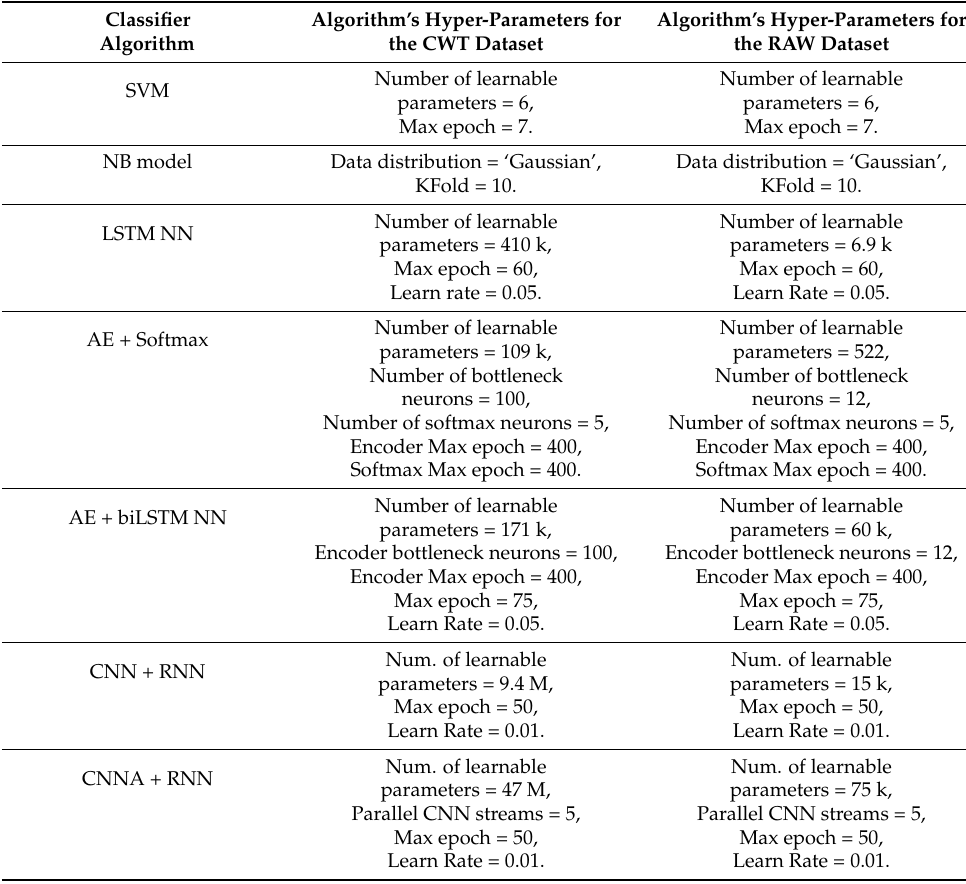
Classifier Algorithm